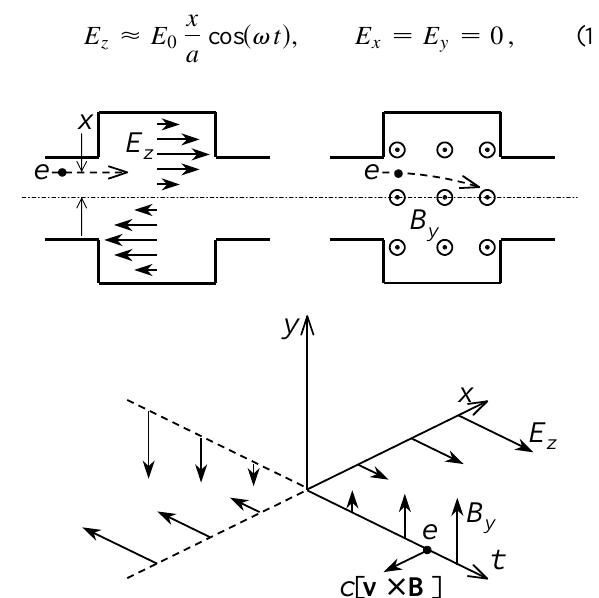
FIG. 1. Electric field (top left) in a dipole mode cavity at synchronous time ( t (cid:1) 0 ), and the magnetic field (top right) one-quarter oscillation later. Longitudinal electric and vertical magnetic fields around t (cid:1) 0 (bottom). 1098-4402 (cid:4) 02 (cid:4) 5(8) (cid:4) 084001(9)$20.00 © 2002 The American Physical Society